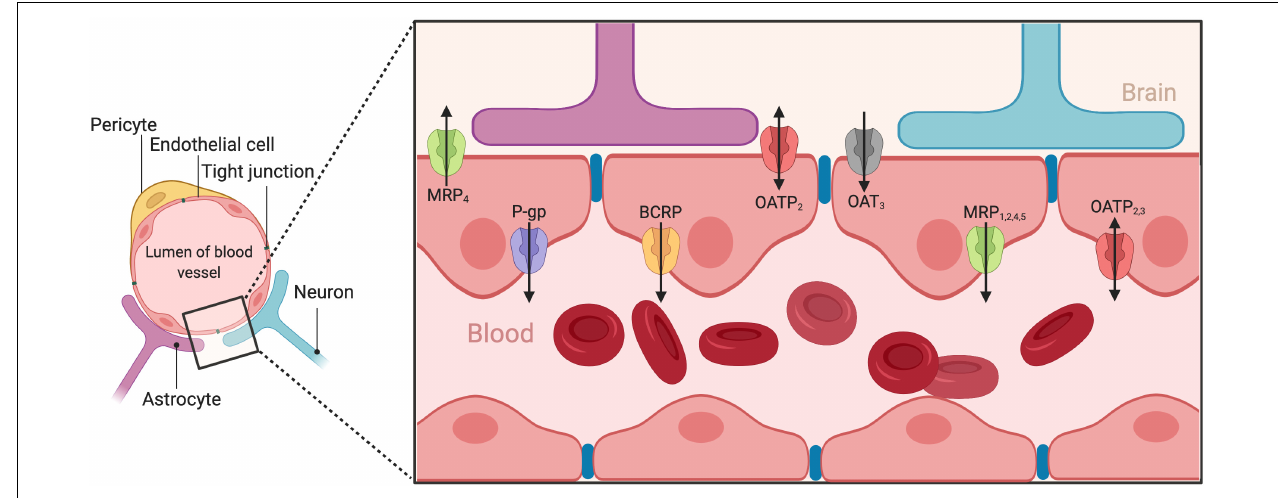
FIGURE 1 | Graphical representation of the blood–brain barrier and its